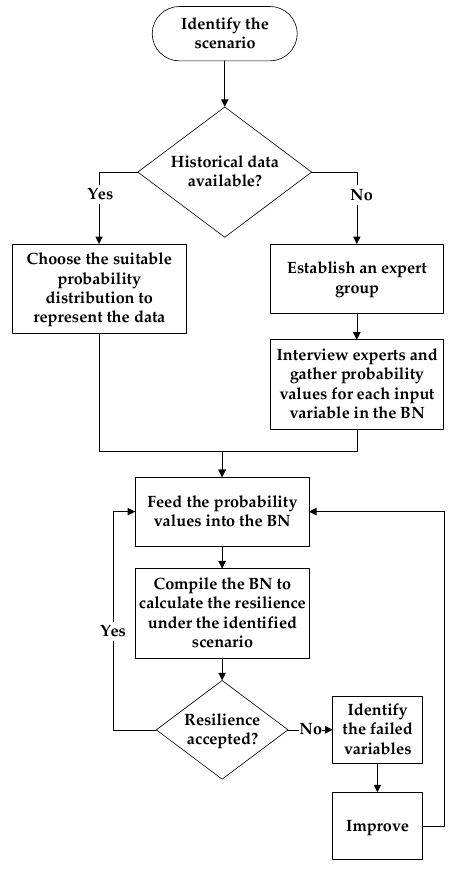
Figure 2. Methodology followed to estimate the resilience of WFs using